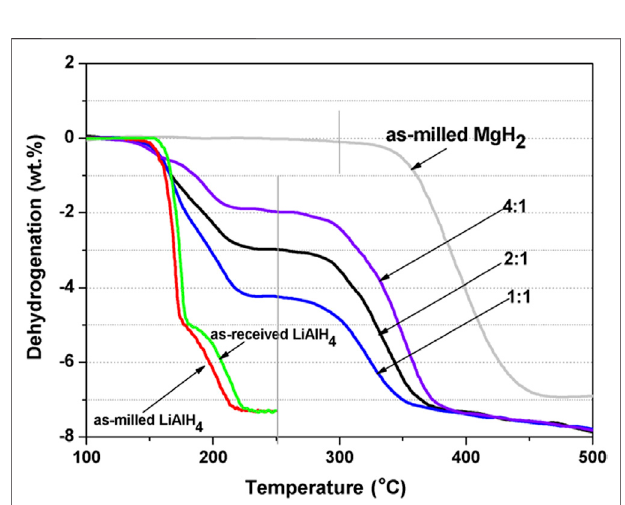
FIGURE 3 | Initial desorption temperature for the as-milled LiAlH 4 , as- milled MgH 2 , and MgH 2 – LiAlH 4 composites with different molar ratios (1:1, 2: 1, and 4:1) (Zhang et al., 2008).